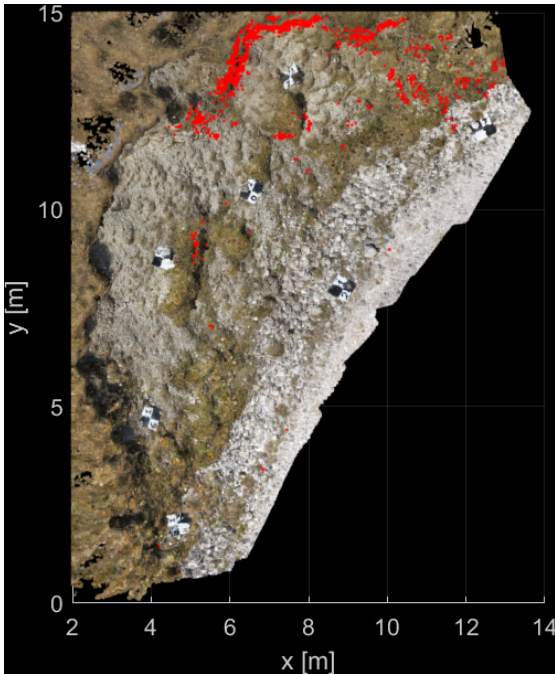
Figure 5. Comparison between UWB and vision-based positioning. (a) 2D root mean square error (RMSE), (b) height error distribution.